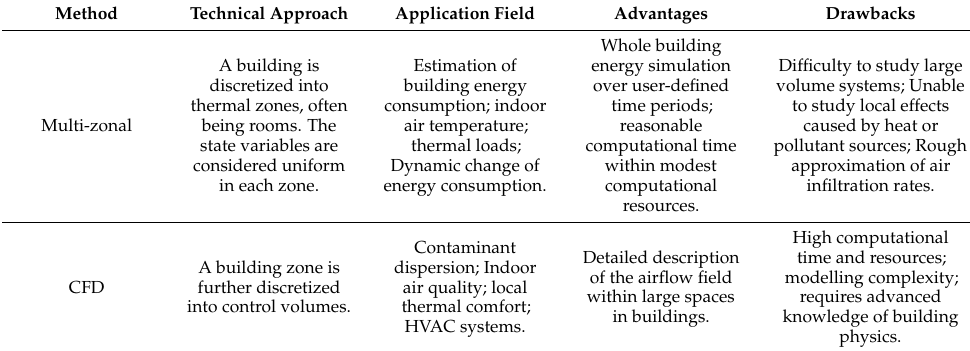
Table 1. Collation of major building physics’ simulation